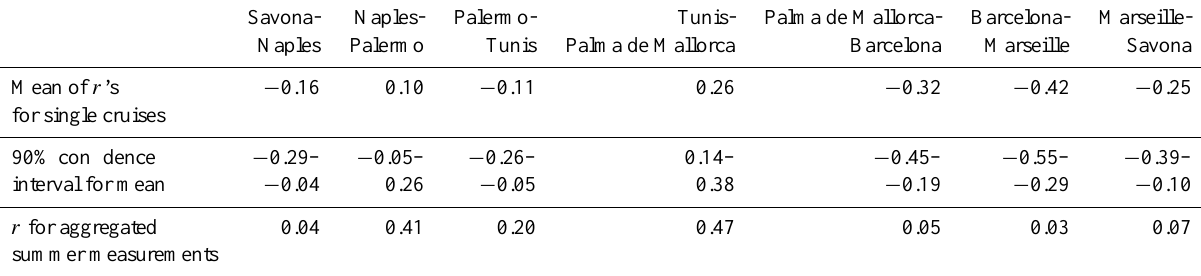
Table 3. Mean values and 90% confidence intervals (assuming normal distribution) for the correlation coefficients (Pearson’s correlation) for BC vs. ozone for each leg of the cruise for the period June, July and August in 2006 and 2007. In the first row, correlation coefficients have been calculated for each journey and then averaged. In the last row, the correlation coefficients for the aggregated data are shown Savona- Naples- Palermo- Tunis- Barcelona- Naples Tunis Mean of r ’s − 0.16 0.10 − 0.11 for single cruises interval for